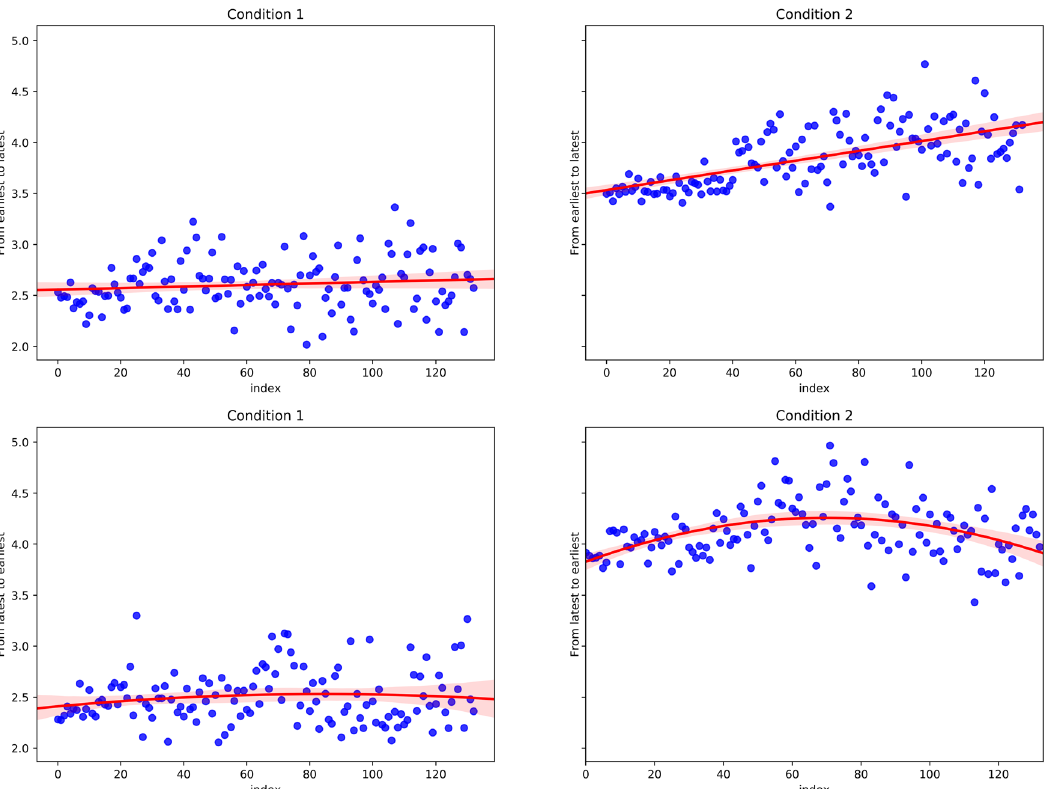
Fig. 7 Correlation of troll coef fi cients with sample indices. Two experimental conditions with comments sorted from earliest to latest and form latest to earliest.